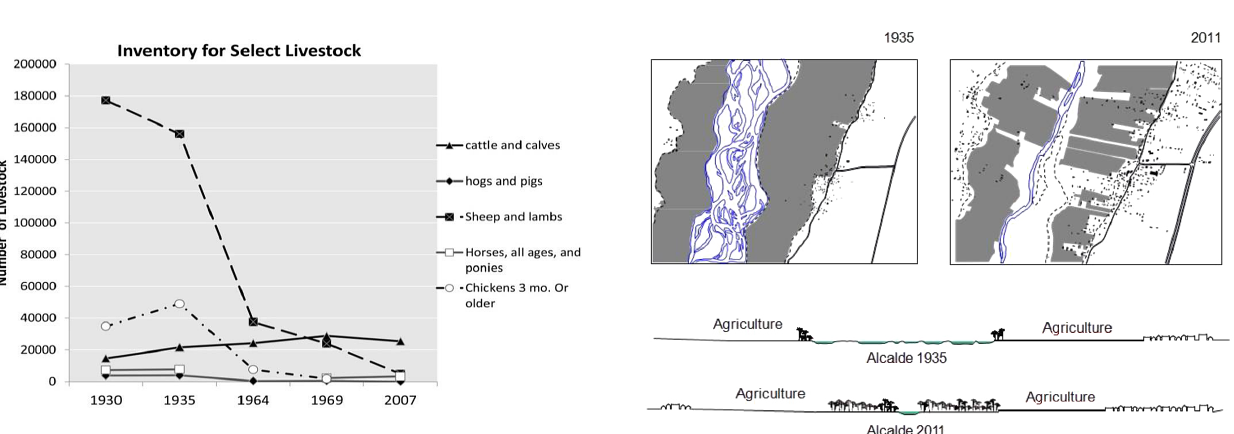
Figure 6. Inventory of livestock 1930–2007, Rio Arriba County (NASS, 2012; USDC/USDA, 2014).